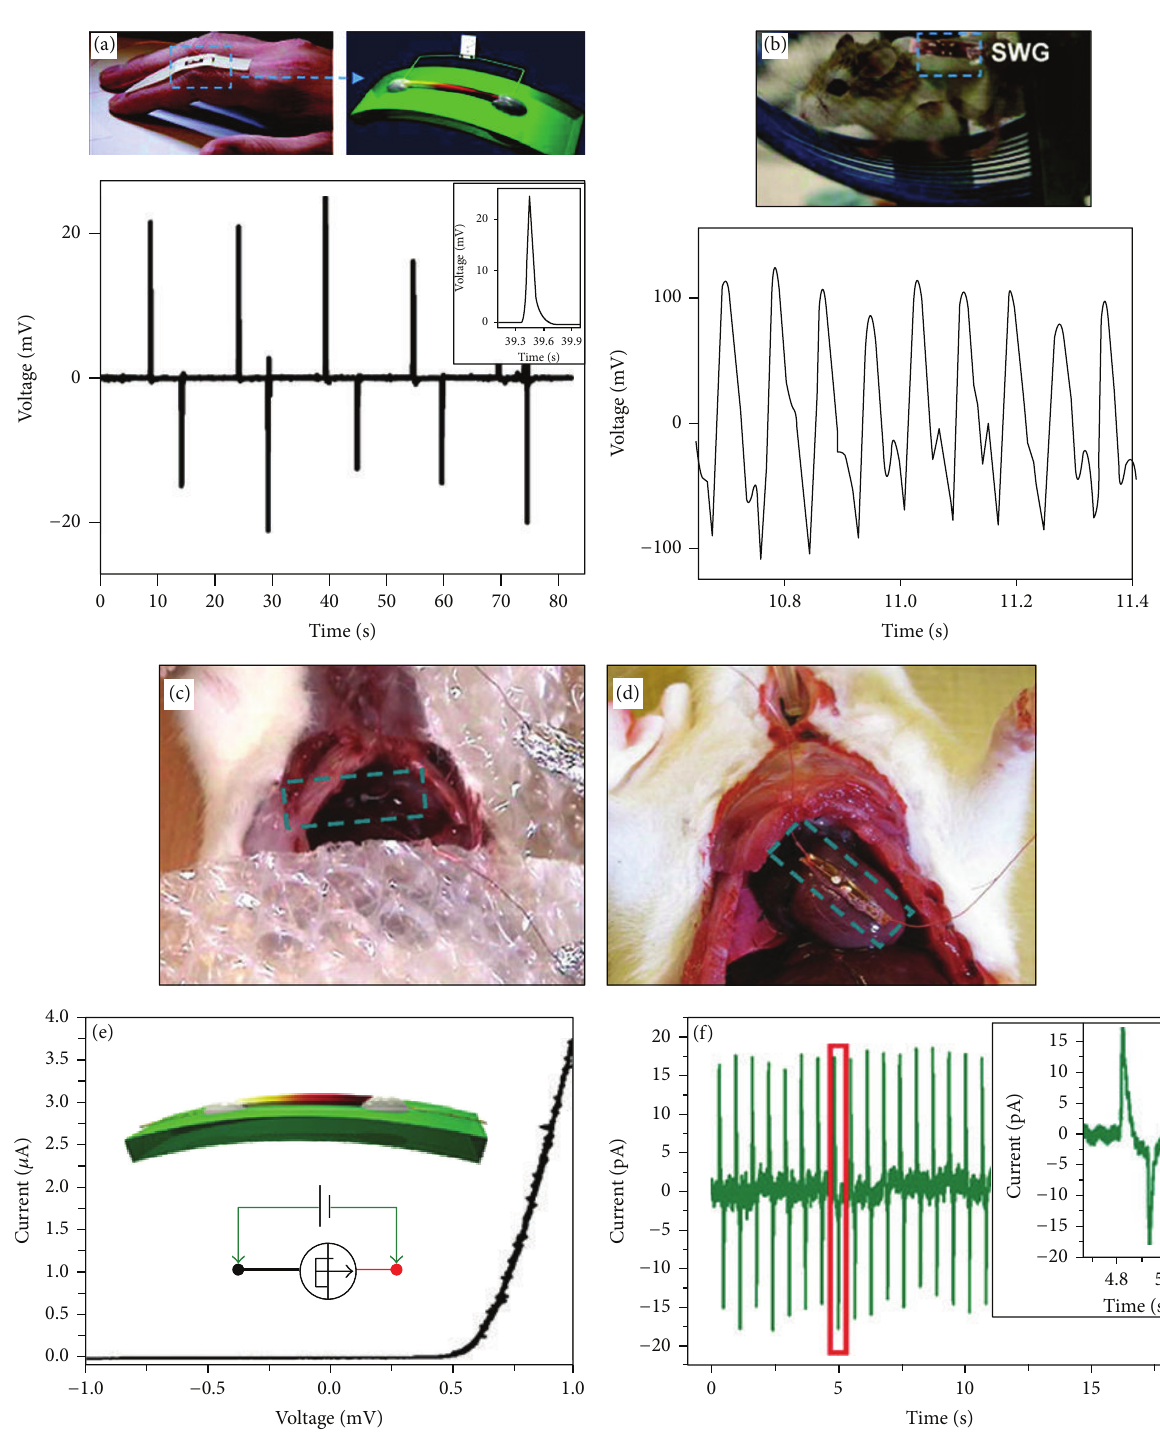
Figure 13: The application of single wire nanogenerator for harvesting the biomechanical energies. (a) Finger bending. (b) Hamster running. (c) Rat breath. (d) Rat heartbeat. (e) I-V characteristic. (f) Generated current from the heartbeat of rat. [Reproduced from [63, 64] with the permission from American Chemical Society and Copyright WILEY-VCH Verlag GmbH & Co. KGaA,